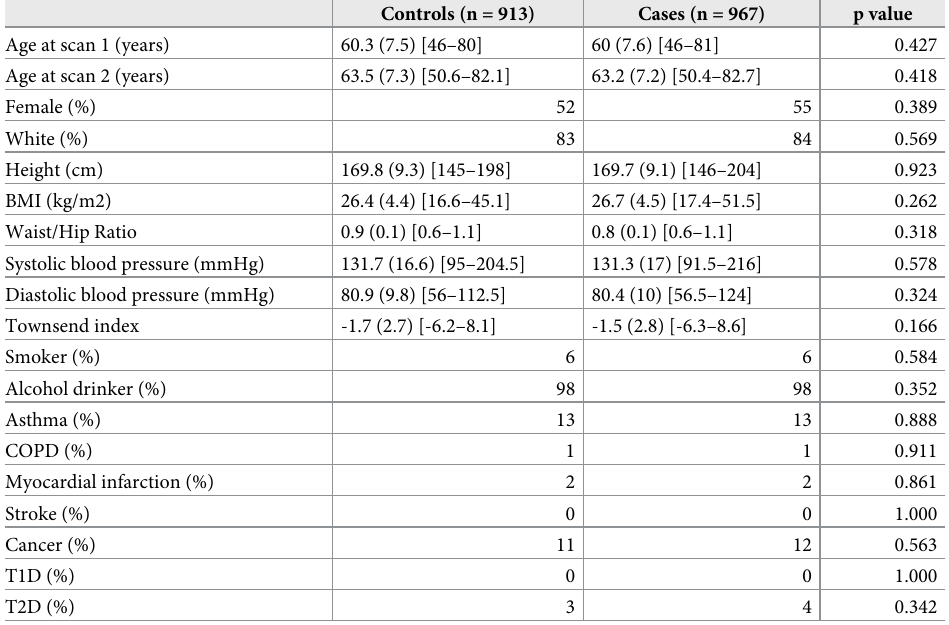
For continuous variables, mean, standard deviation, and range are shown.COPD, chronic obstructive pulmonary disease. BP, blood pressure. Unadjusted p-values are shown from Student’s t-test or Chi-squared goodness-of-fit tests respectively for continuous and binary variables. P-values with an asterisk ( * ) are statistically significant with FDR �